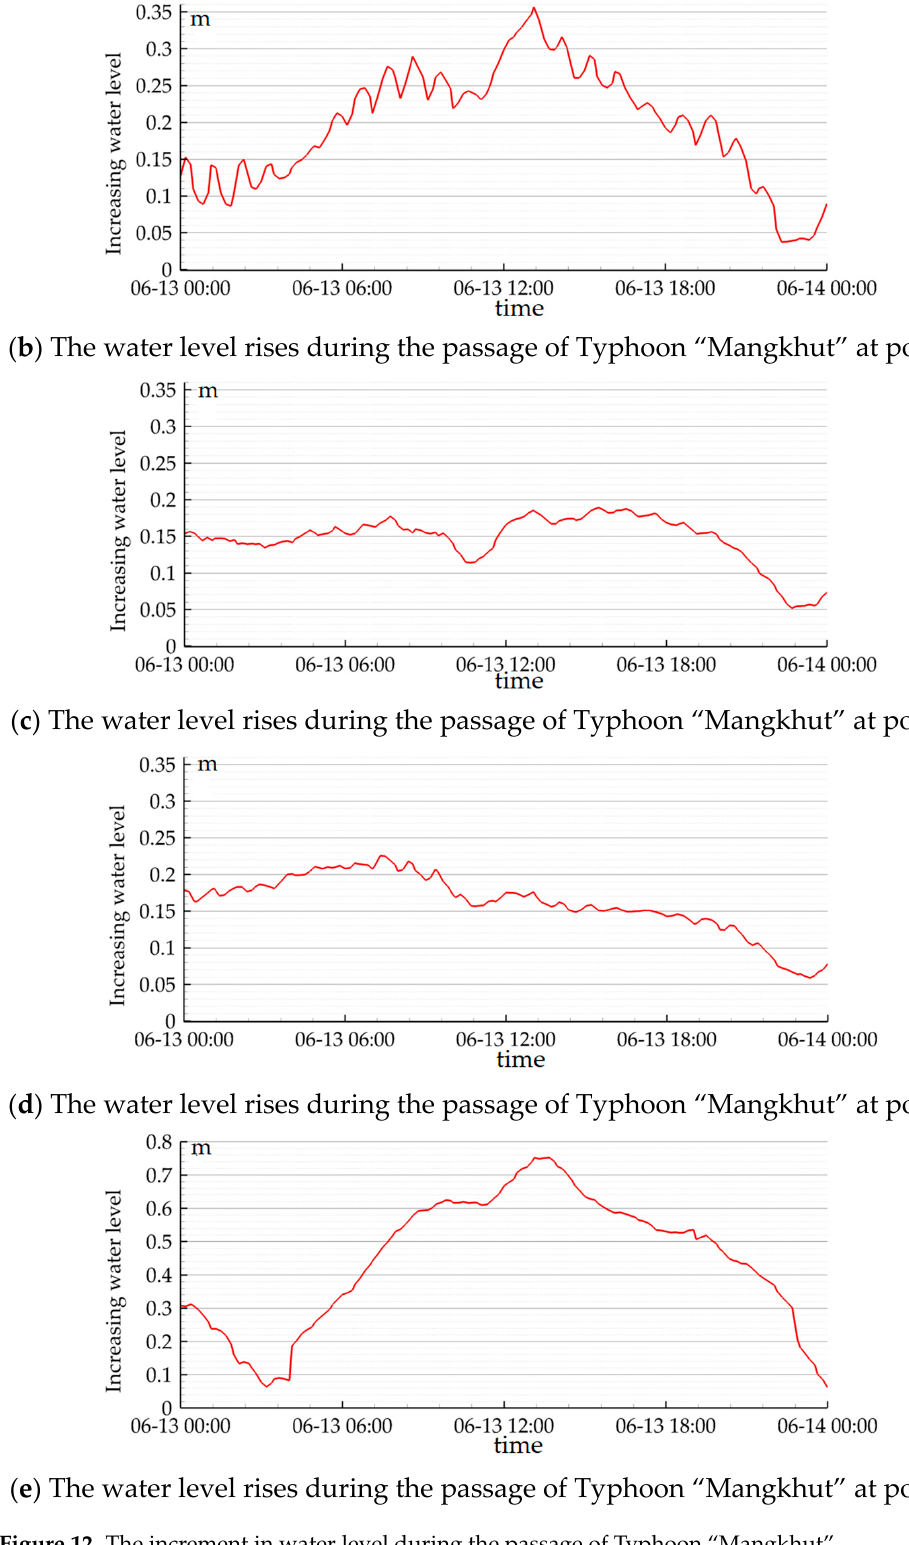
Figure 12. The increment in water level during the passage of Typhoon “Mangkhut.”